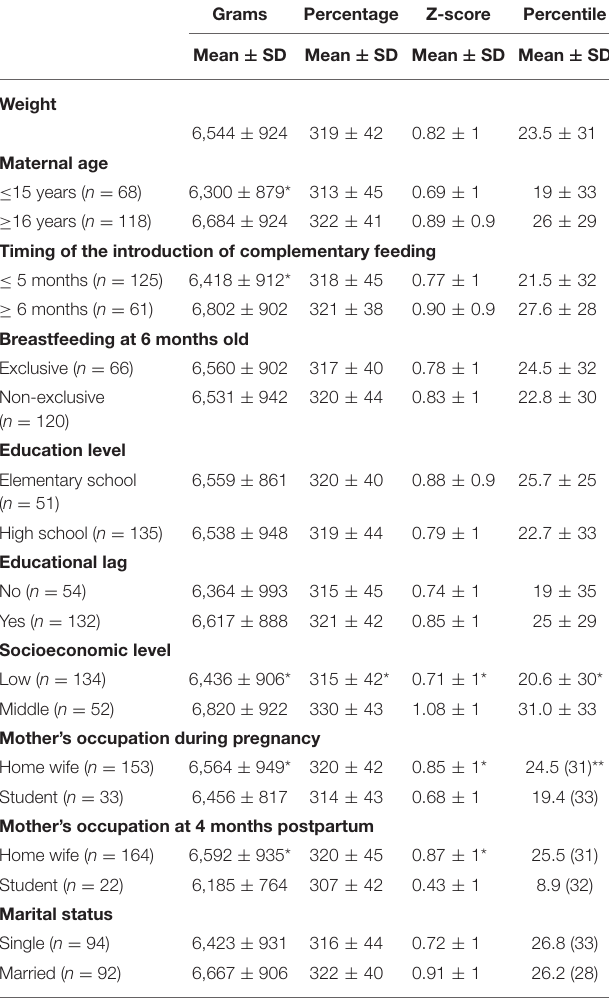
TABLE 2 | Weight change (delta) from birth to 12-months-old, according to maternal sociodemographic